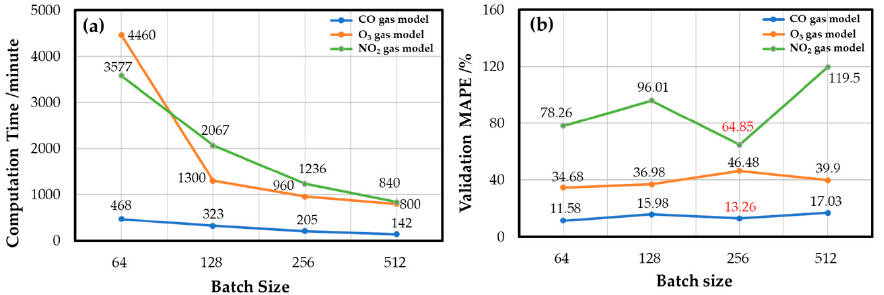
Figure 10. Batch size effect of each gas model: ( a ) computation time and ( b ) the convergence as the validation MAPE.